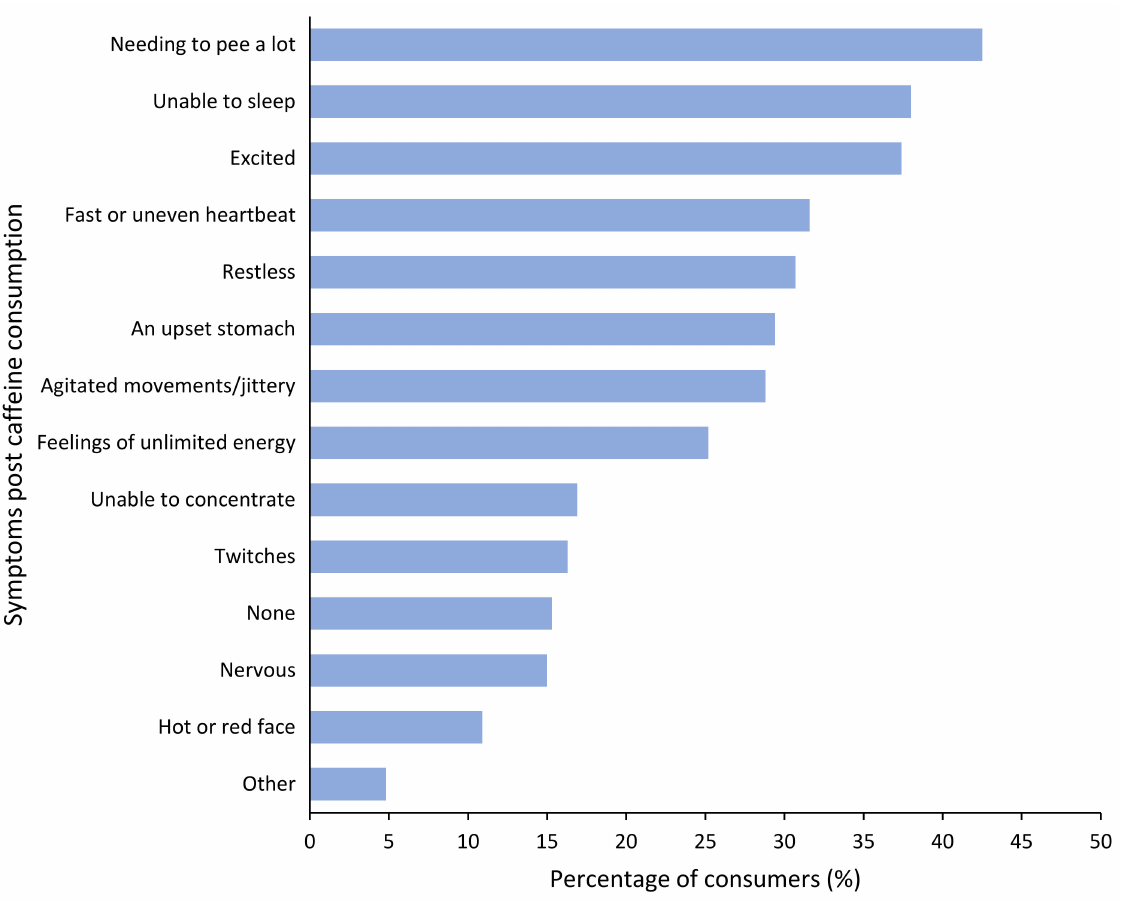
Figure 1. Perceived ‘adverse symptoms’ post consumption of caffeine ( n = 314).